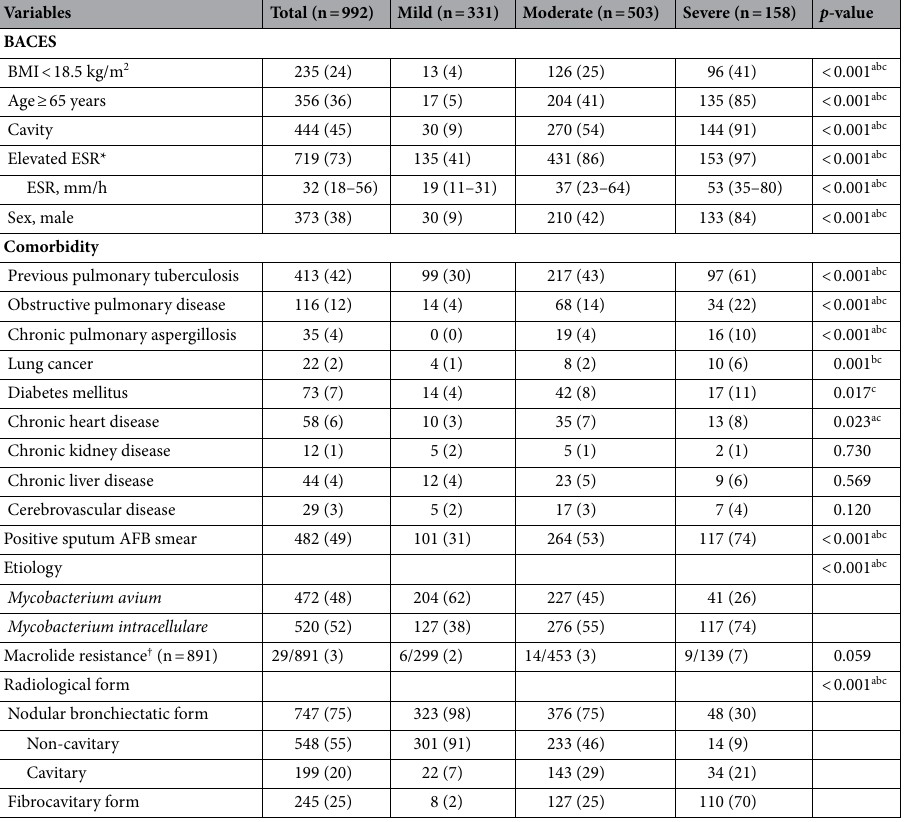
Table 1. Baseline characteristics of study patients according to BACES severity. Data are presented as n (%) or median (interquartile range). BACES BMI, age, cavity, ESR, and sex, BMI body mass index, ESR erythrocyte sedimentation rate, AFB acid-fast bacilli. *Elevated ESR: > 15 mm/h in men and > 20 mm/h in women. † 891 patients had information on macrolide susceptibility testing. a p < 0.05 with Bonferroni correction between mild and moderate groups. b p < 0.05 with Bonferroni correction between moderate and severe groups. c p < 0.05 with Bonferroni correction between mild and severe groups.